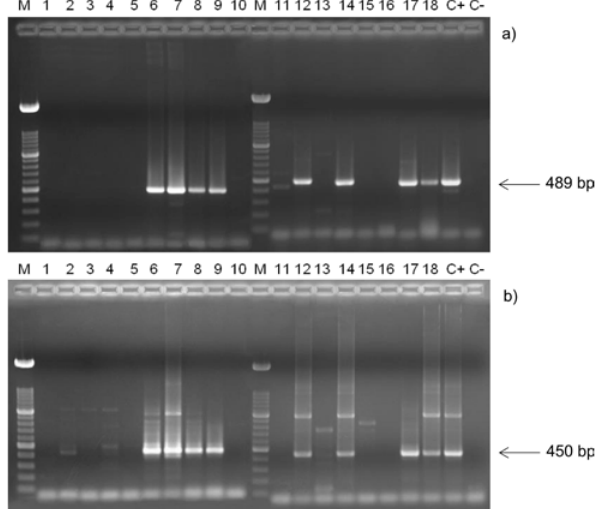
Figure 2. Agarose gel electrophoresis of PCR products that were amplified with Phytophthora cinnamomi -specific primer pairs LPV2 (a) and LPV3 (b), showing amplified fragments of sizes 489 and 450 bp, respectively. M, 100- bp size marker. C+, positive control ( P. cinnamomi PcH15); C–, negative control. P. cinnamomi , lines 6-9, 12, 14, 17-18 (isolates C006, C007, C012, C014, C017, C018, C025,